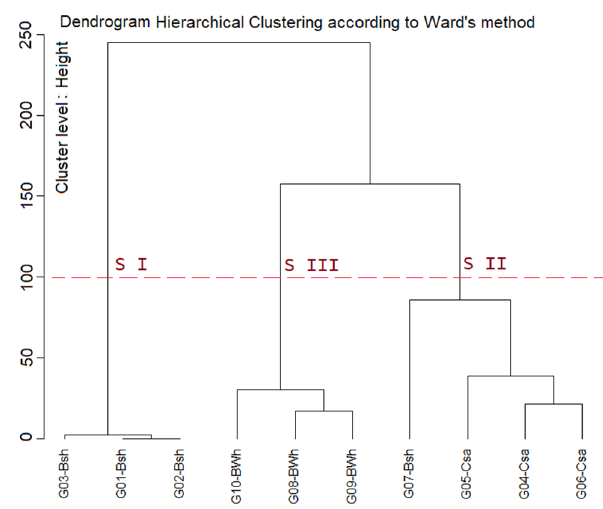
Figure 11. Hierarchical relationships among the LULC, gauge sites, and climate zones. Clustering analysis was performed following Ward’s method (e.g., [53]). The study area was classified into three exclusive scenarios based on a combination of internal variables, such as the climate patterns, and this classification was applied to identify different LULC groups by clustering sites with similar climate patterns.